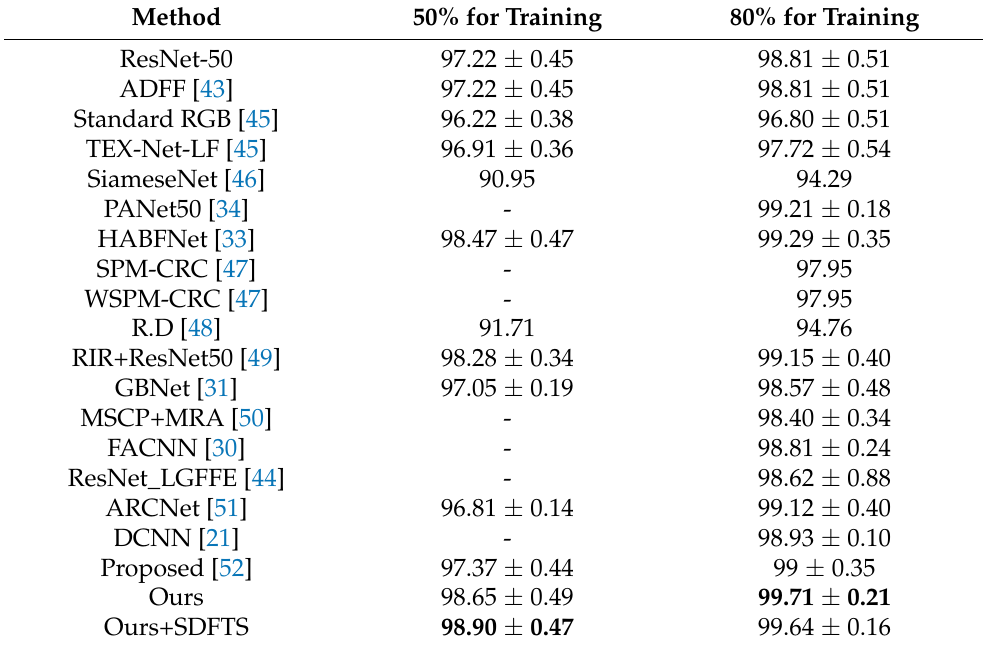
Table 5. The performance comparison on the UC Merced Land-Use dataset. SDFTS represents the stochastic decision-level fusion training strategy. The bold values denote the best performance of different training